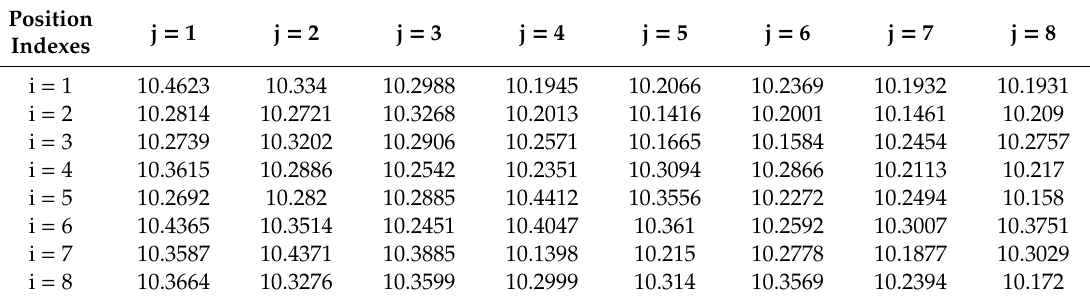
Table 3. Estimated strain (%) using a digital microscope.